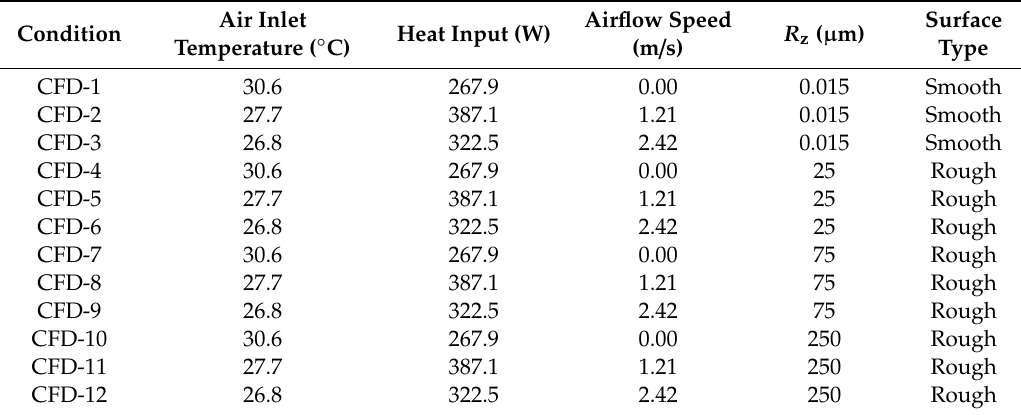
Table 5. The considered conditions of the convective heat transfer coe ffi cients prediction.